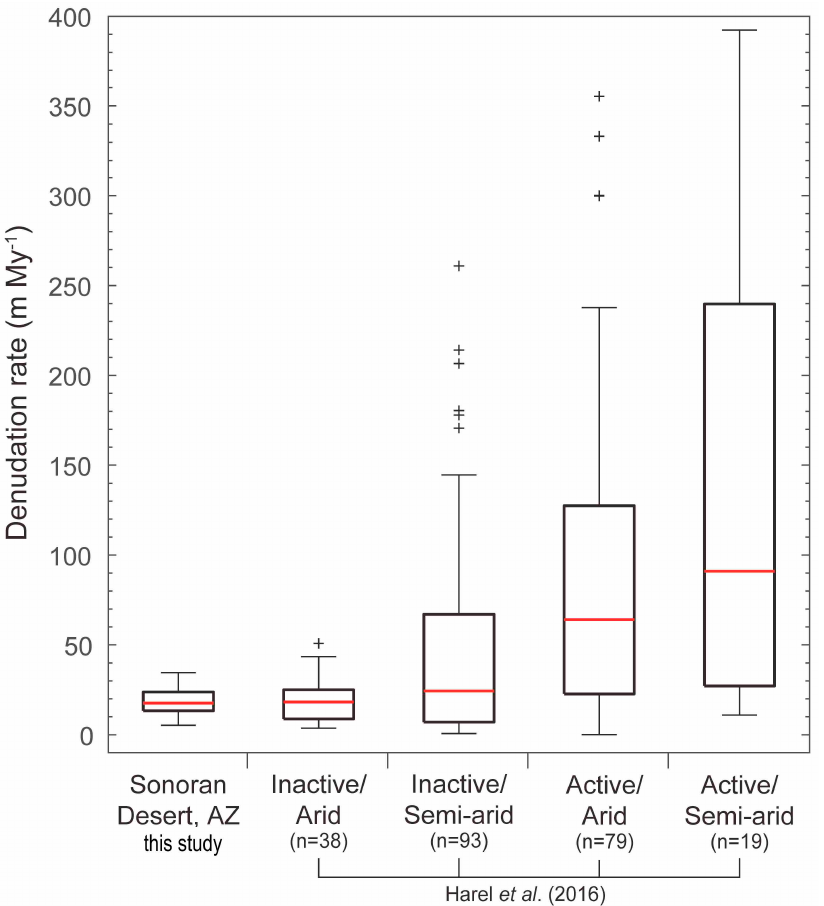
Figure 10. Box plots comparing the 10 Be denudation rates we observed in the tectonically inactive Sonoran Desert with a global-scale 10 Be denudation analysis [90]. Inactive/arid regions have a seismicity < 2 categorized by Harel et al. [90] and a mean annual precipitation (MAP) of <250 mm. Inactive/semiarid regions also have a seismicity < 2 categorized by Harel et al. [90] but a mean annual precipitation (MAP) of greater than 250 mm but less than 500 mm. Active/arid regions have a seismicity > 2 categorized by Harel et al. [90] and a mean annual precipitation (MAP) of <250 mm. Active/semiarid regions also have a seismicity > 2 categorized by Harel et al. [90] but a mean annual precipitation (MAP) of > 250 mm but < 500 mm.